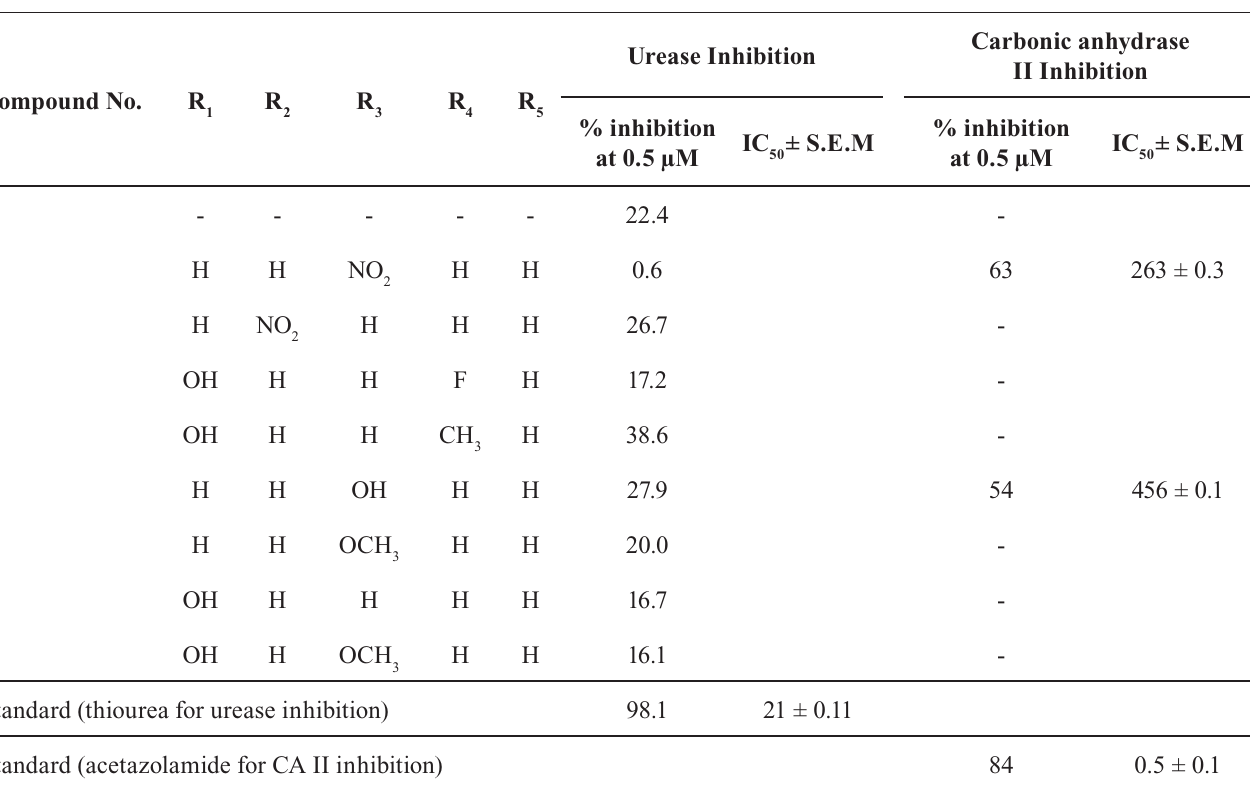
TABLE III - Enzyme inhibition activity of 4-Hydroxycoumarin derivatives